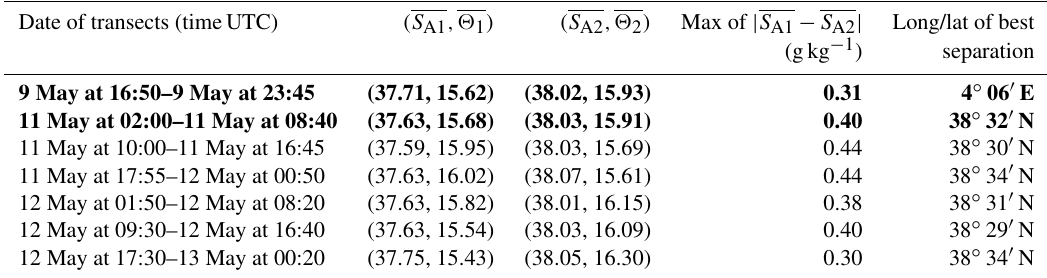
Figure 5. Vertical sections of conservative temperature (cid:50) (a, d) , absolute salinity S A (b, e) and density ρ (c, f) , sampled by the SeaSoar along the WE transect (a–c) and along the NS transect (d–f) . The SeaSoar trajectory is represented by the black lines. The triangle indicates the location of the front area between the two types of AW represented in light and dark blue (see Fig. 4b and d respectively). Table 1. Results of the iterative algorithm to determine the best separation between the two types of AW along the SeaSoar transects of the WE and NS hippodromes. The lines in bold correspond to the WE and the NS transects represented in Fig. 4. Only one transect is available for the WE hippodrome due to technical problems encountered with the towed